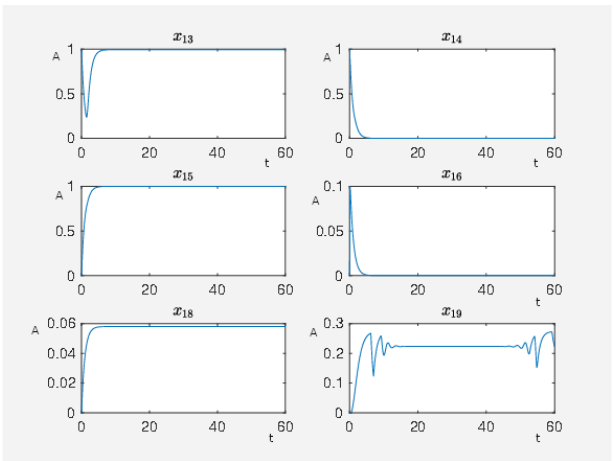
Figure 10. On the abscissa, we have the time (t) and on the ordinate the activity level (A) for PKC (node 13), RKIP (node 14), RKIP dim (node 15), GRK2 (node 16), isoproterenol (node 18) and G s -coupled β β 1 receptor (node 19) where the G s -coupled 1 receptor is